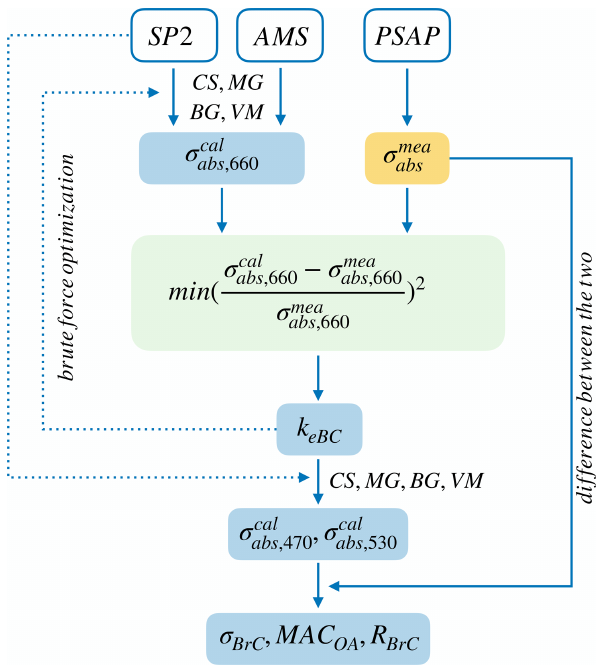
Figure 2. Schematic diagram of the iterative derivation of BrC ab- sorption attribution performed in this study. Cells in white, yellow, and blue represent instrument, measurements, and calculations, re- spectively. The green box is the optimization step used to determine the values of the imaginary part of the effective refractive index of BC, k eBC , once the deviation of measured and calculated absorption coefficients at 660nm ( σ cal and σ mea ) is minimized. k eBC abs , 660 abs , 660